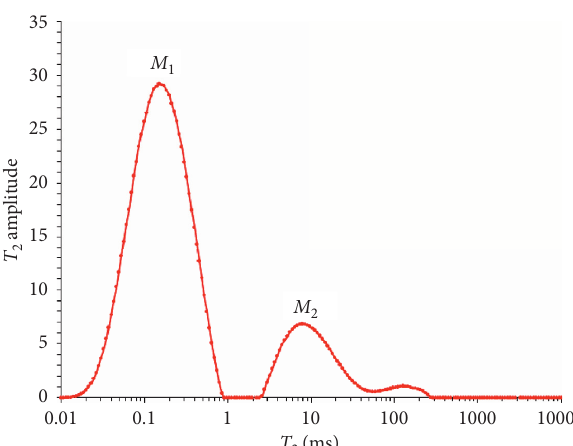
Figure 4: Calibration curve.